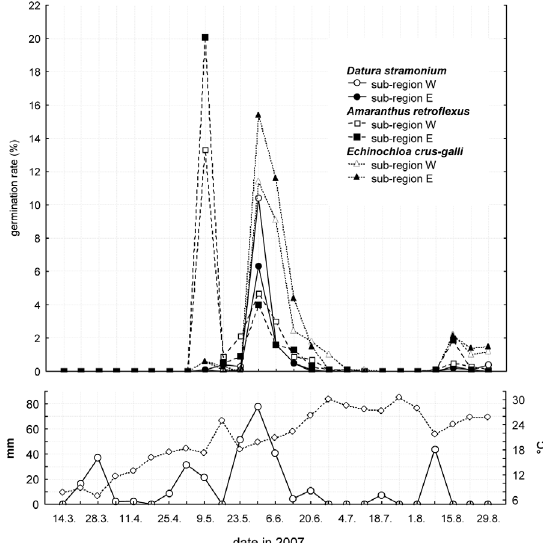
Figure 3. Mean seed germination rates of A. retroflexus , E. crus- galli , and D. stramonium , originating from two sub-regions of Kosovo, in a germination experiment under field conditions. W = western part of Kosovo, E = eastern part of